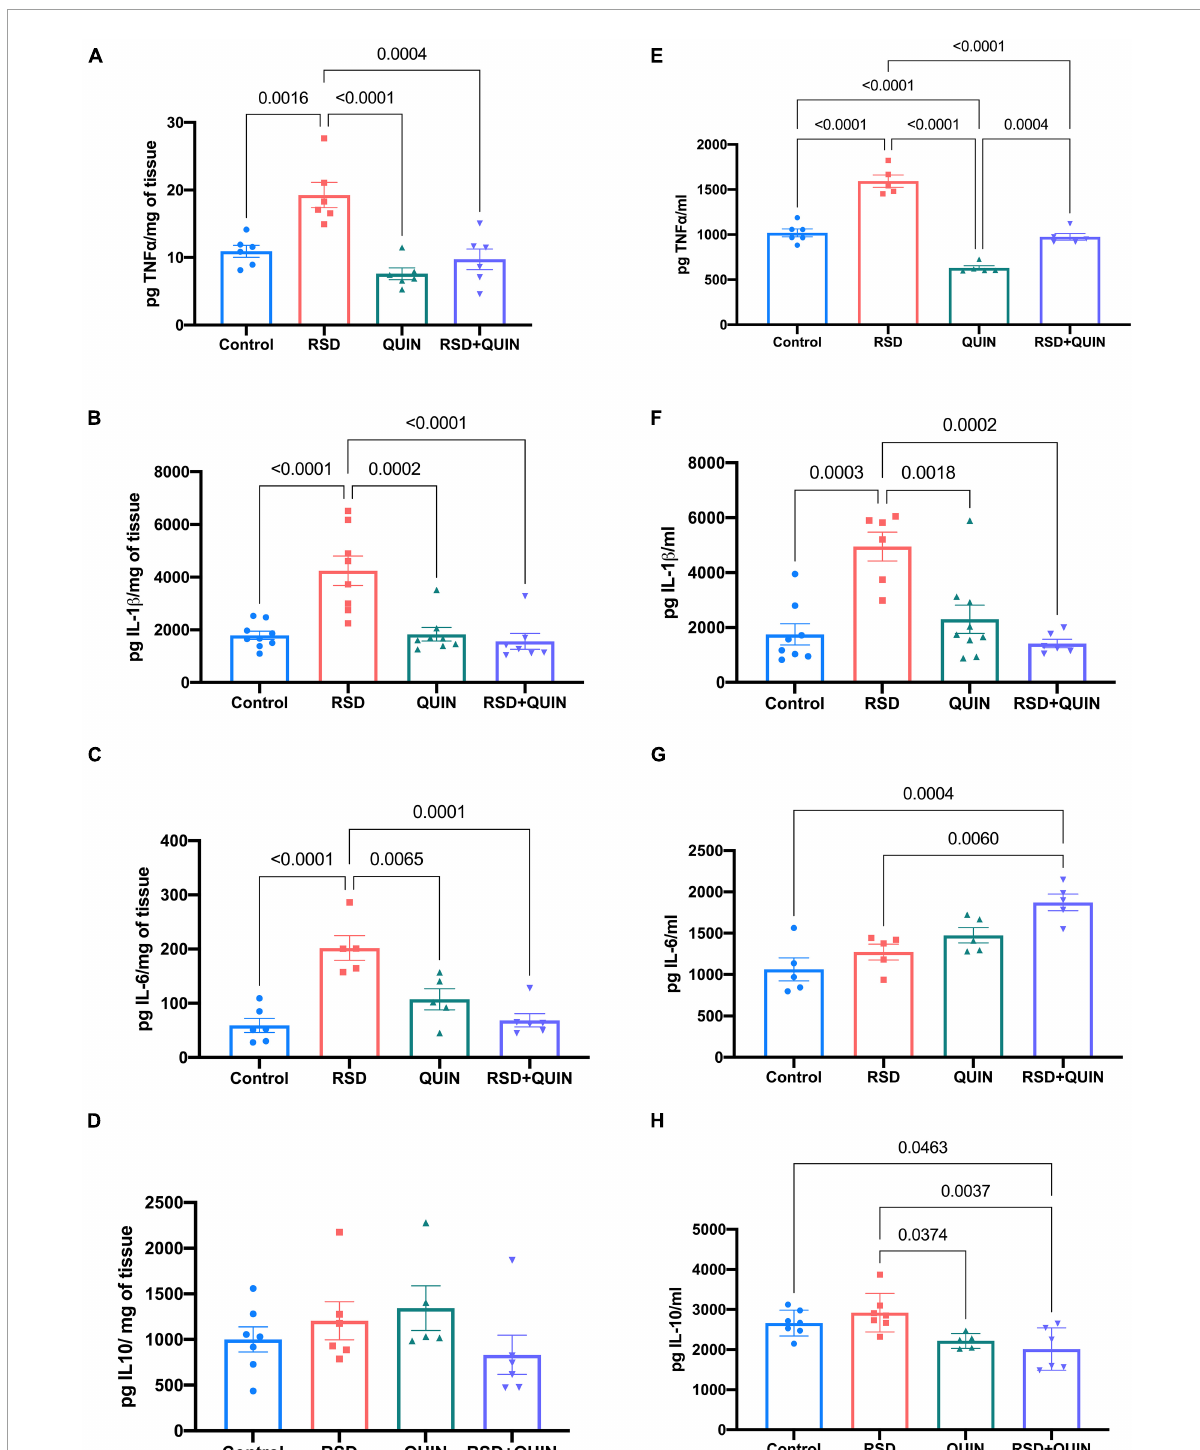
FIGURE3 Quinpirole (QUIN) attenuated the increases in the levels of proinflammatory cytokines evoked by REM sleep deprivation (RSD). Effect of QUIN on hippocampal and serum cytokine levels in RSD mice. Mice were administered QUIN (2 mg/kg/day for 3 days) and subjected to RSD. The levels of TNF- α (A) , IL1 β (B) , IL6 (C) , and IL10 (D) in the hippocampus and TNF- α (E) , IL1 β (F) , IL-6 (G) , and IL-10 (H) in serum were analyzed by ELISA. Data are presented as means ± SEM and were analyzed using one-way ANOVA, followed by Tukey’s post-hoc test. For hippocampus TNF- α n = 6, IL-1 β n = 7–9, IL-6 n = 5–6, and IL-10 n = 5–7, for serum TNF- α n = 5–6, IL-1 β n = 6–8, IL-6 n = 5, and IL-10 n = 5–7. Significant differences among the experimental groups are